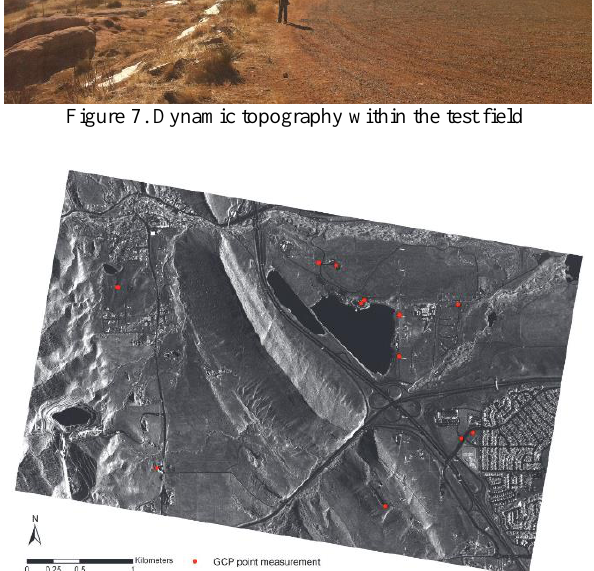
Figure 8. TerraSAR-X dataset and GCPs surveyed on the ground with GNSS.